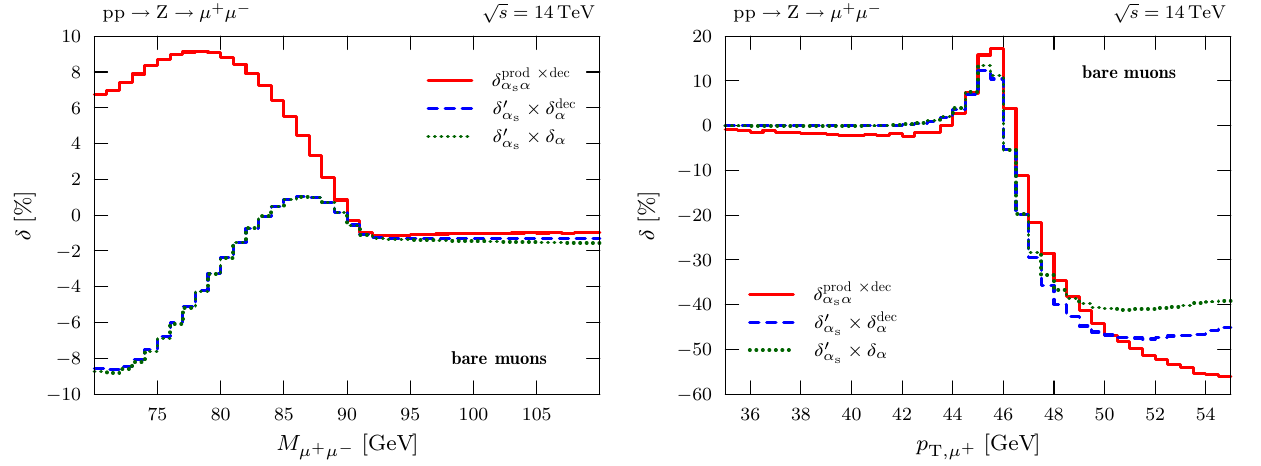
Fig. 37 Relative factorizable corrections (in red ) of O (αα s ) induced by initial-state QCD and final-state EW contributions to the lepton- invariant-mass distribution ( left ) and a transverse-lepton-momentum